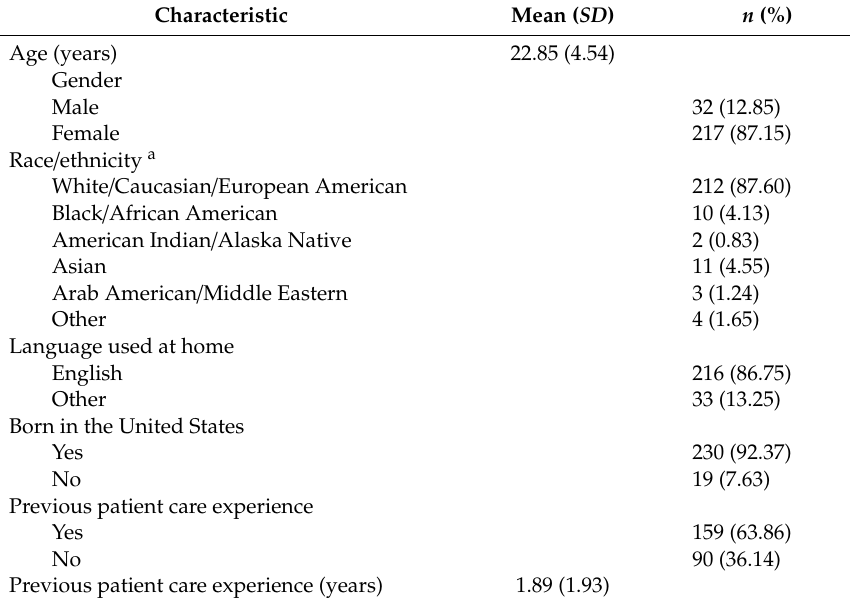
Table 1. Demographic Characteristics of Participants ( N =